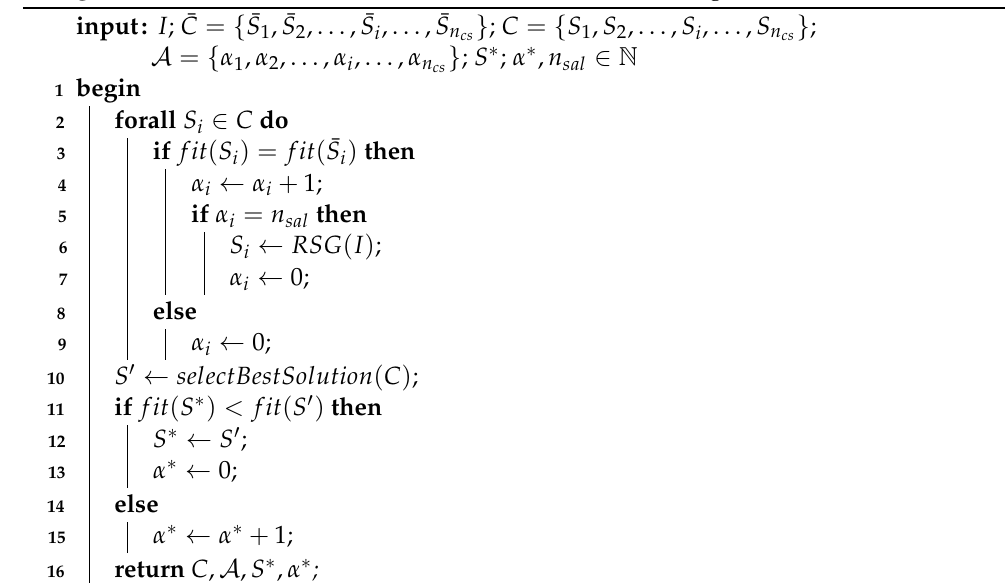
Algorithm 5: scoutBP (Scout Bee Phase of the CARP-ABC